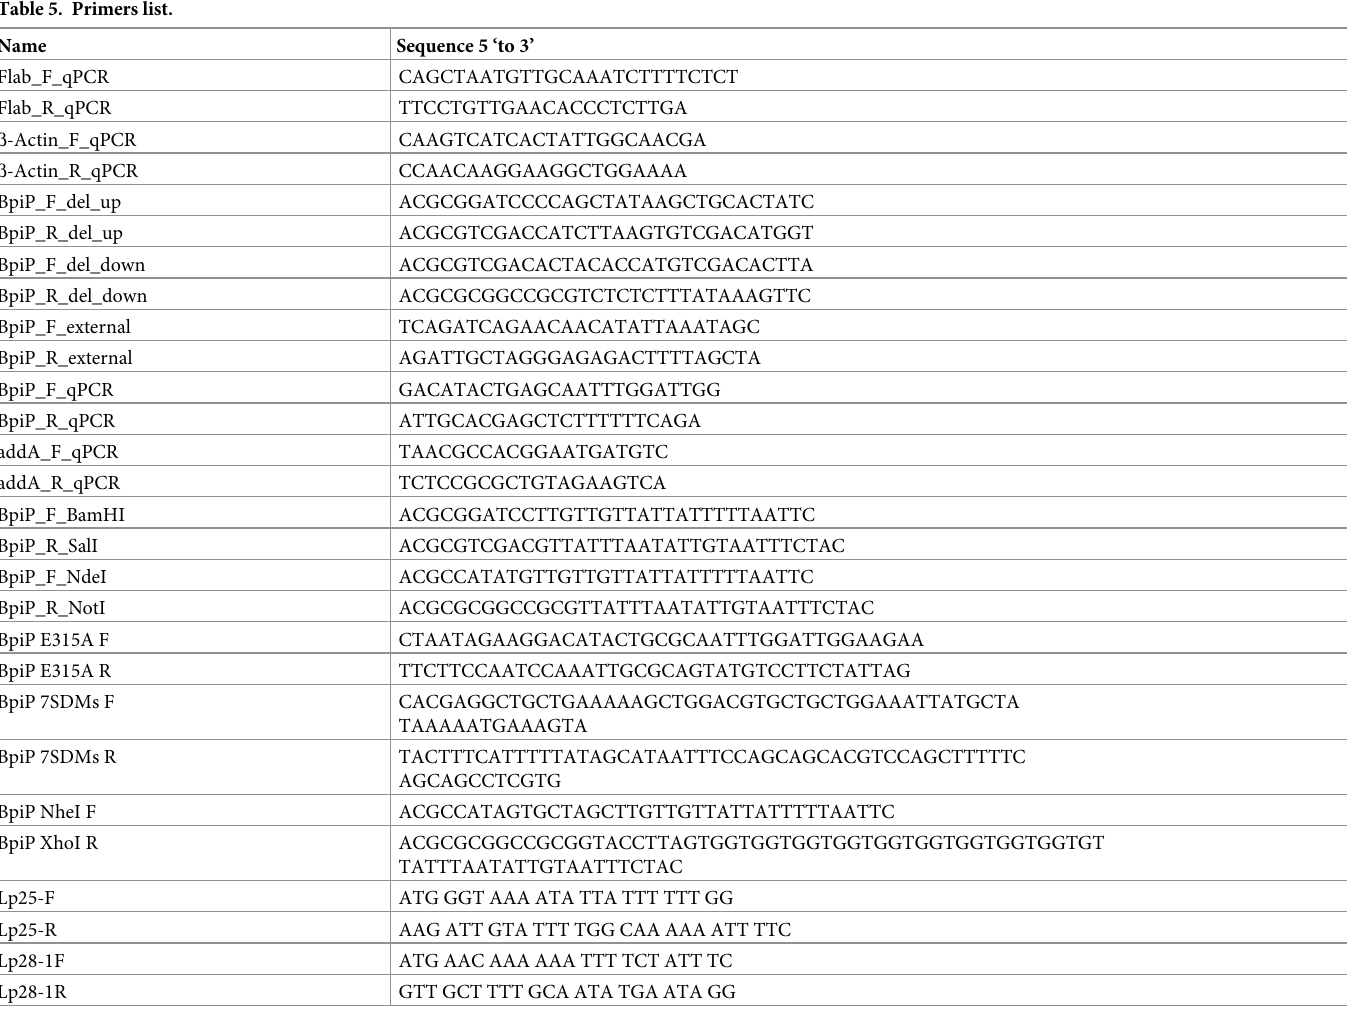
Table 5. Primers